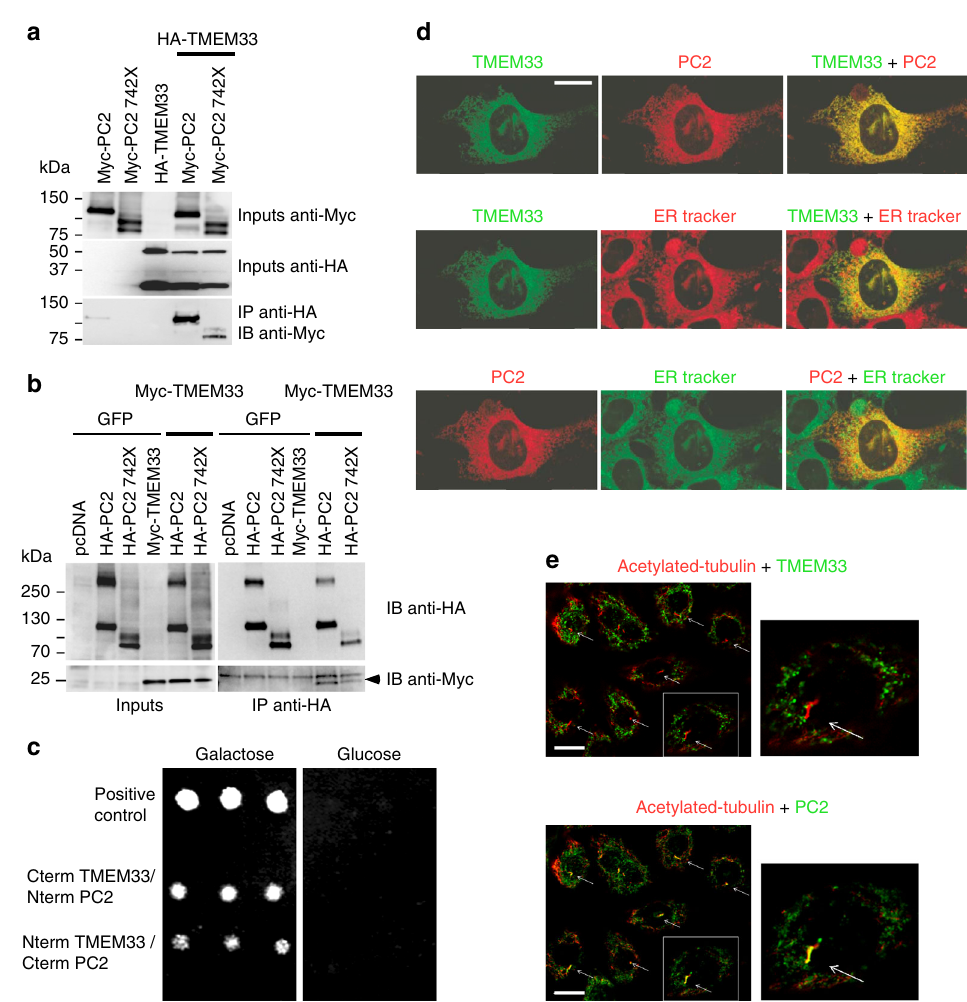
Fig. 1 TMEM33 interacts with PC2 at the ER membrane of PCT cells. a Co-immunoprecipitation of TMEM33 with PC2 in PCT cells when TMEM33 is pulled down. A pathologic PC2 deletion mutant PC2 – 742X was also tested. b Same, but when PC2 is pulled down. Arrowhead indicates TMEM33 and the upper band is non-speci fi c. c Yeast two hybrid experiments indicating an interaction (direct or indirect) between TMEM33 and PC2. We used a yeast strain with chromosomal LEU2 reporter gene harboring LexA operator binding sites. As a second reporter we used GFP under the control of the LexA operator (URA). The bait was either the COOH or NH2 terminus of TMEM33 expressed in frame with LexA (HIS), and the prey was either the COOH or NH2 terminus of PC2 expressed in frame with B42. As a further selection the prey product is only expressed in the presence of galactose. For a positive interaction, the yeast need to grow on medium -HIS-TRP-URA-LEU + Galactose and light up positive for GFP. As a positive control we used LexA-p53 with B42-LTA. As negative controls, we either expressed the LexA-CtermTMEM33 with the empty prey vector or B42-CtermPC2 with the empty bait vector. No growth was observed with any combination of either prey alone or bait alone. d Top: Co-localization of TMEM33-GFP (green) and mCherry-PC2 (red) in PCT cells; Middle: co-localization of TMEM33-GFP (green) with ER tracker as an ER marker (red); Bottom: co-localization of mCherry-PC2 (red) with ER tracker (green). The merged image (yellow shows co-localization) is shown at the right. False colors were used to consistently illustrate co-localizations in yellow (ER tracker blue). The scale bar corresponds to 20 μ m. e TMEM33 is absent at the primary cilium, unlike PC2. Acetylated-tubulin in red labels the primary cilia and TMEM33 (top panels) or PC2 (bottom panels) are labeled in green (false colors). Co-localization of PC2 and acetylated tubulin is seen in yellow (merged image; bottom panels). The right panels are magni fi cation of the boxed area shown in the left panels. Arrows indicate primary cilia. The scale bar corresponds to 15 μ m. Source data are provided as a Source Data fi fl uorescent reporter in the presence of doxycycline (DOX)(Sup- plementary Fig. 2e). Control cells were the parental TMEM33 − / − PCT cell expressing the repressor together with a CD8 construct